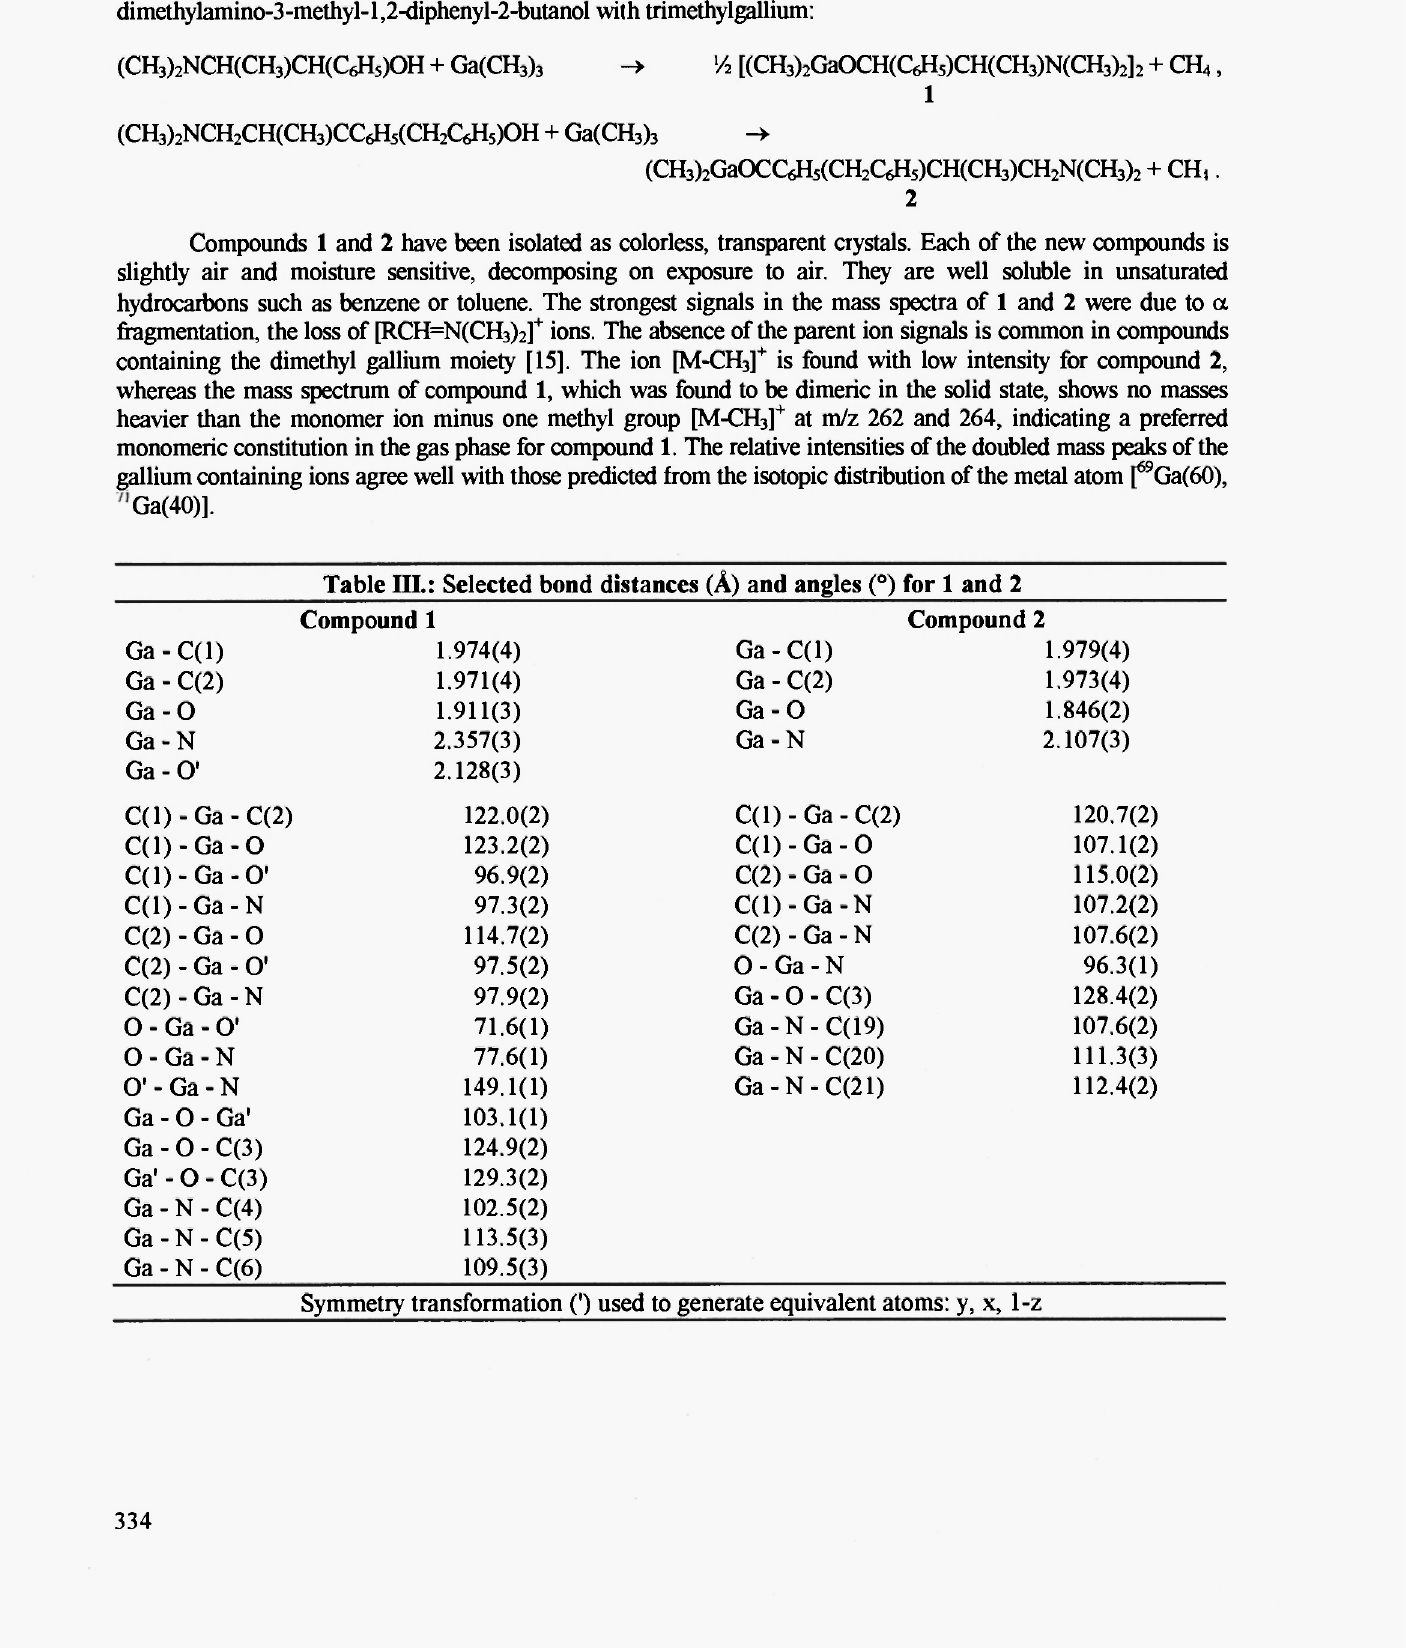
Table III.: Selected bond distances (A) and angles (°) for 1 and